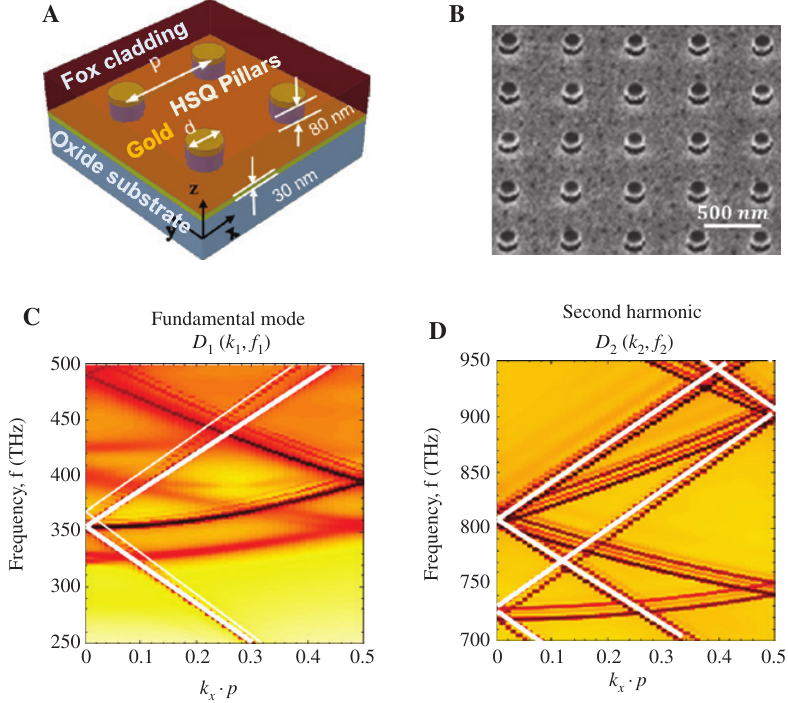
Figure 1: The LP nanostructure and its numerically calculated dispersion at the sweeping range of the excitation pump and the second- harmonic